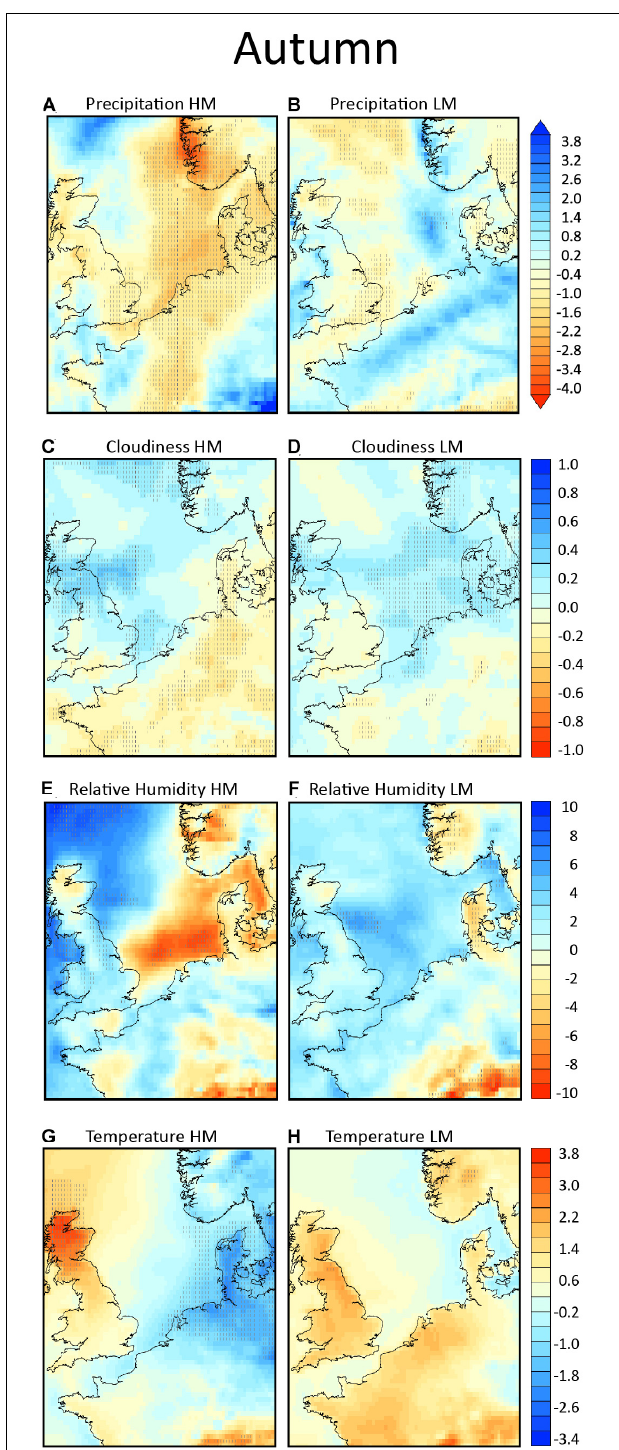
FIGURE 7 | Composites of anomalies from climatology in autumn, in the left column for the high migration nights (HM) and in the right column for the low migration nights (LM). In panels (A,B) the total precipitation (in mm) is shown, in panels (C,D) the total cloud cover (units from –1 to +1), in panels (E,F) the relative humidity (in %) and in panels (G,H) the 2 m temperature field (in ◦ K). Areas exceeding the 95% confidence level are hatched.